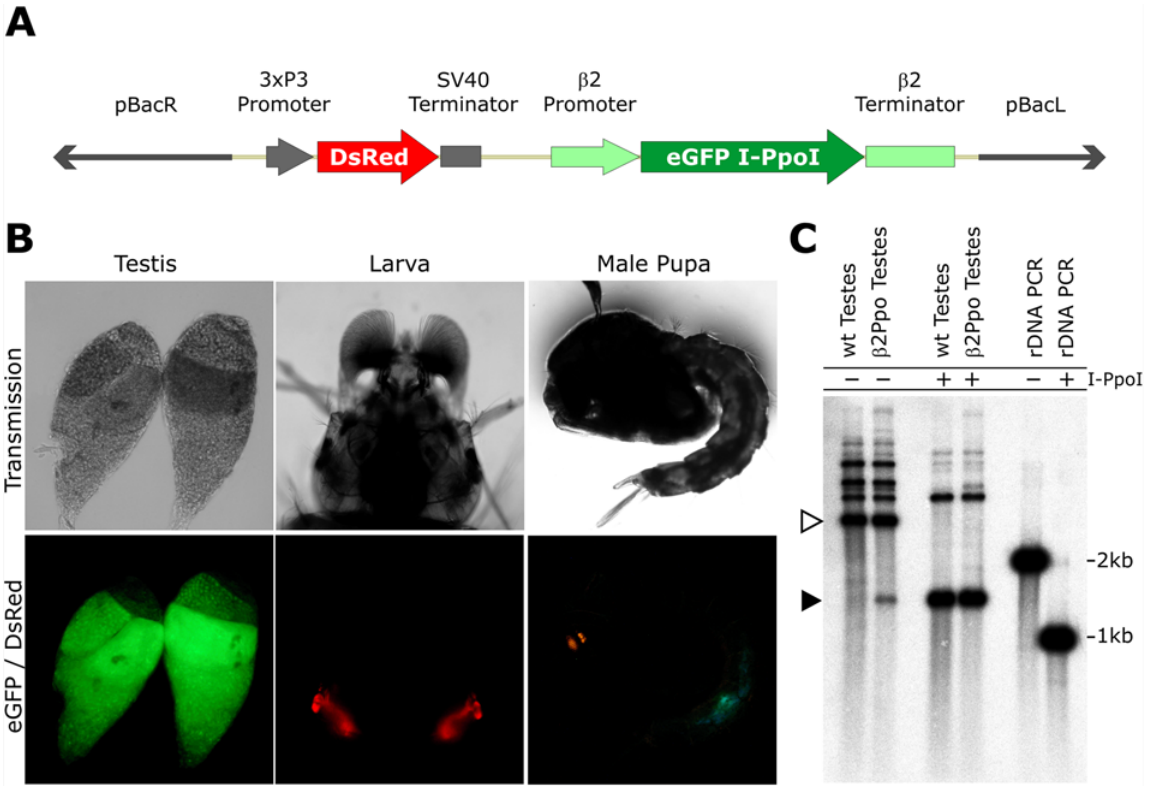
Figure 1. Transformation construct and expression of I-PpoI in the testes of transgenic mosquitoes. (A) Schematic representation of the construct pBac{3xP3-DsRed} b 2-eGFP::I-PpoI containing the left and right piggyBac inverted repeats (pBacR,L); the Pax promoter (3xP3) driving the DsRed marker gene; and the eGFP::I-PpoI effector gene (eGFP I-PpoI) under the control of b 2 tubulin promoter and terminator ( b 2). (B) Transmission and fluorescent images of dissected adult testes, larval head and pupa of b 2Ppo1 male mosquitoes. (C) Southern blot analysis of the 28S ribosomal DNA locus. DNA from testes of WT (lanes 1 and 3) and b 2Ppo1 males (lanes 2 and 4) was digested with the endonuclease ClaI in vitro and hybridized with a probe encompassing the 28S ribosomal gene (Figure S1). As control both the DNA extracted from the WT and b 2Ppo1 testes was treated with recombinant I-PpoI as indicated. Furthermore the PCR product (2kb) used as probe either treated with recombinant I-PpoI or untreated was analysed under the same hybridization conditions (lanes 4 and 5). Open and filled arrowheads indicate the full length and digested rDNA fragments respectively.